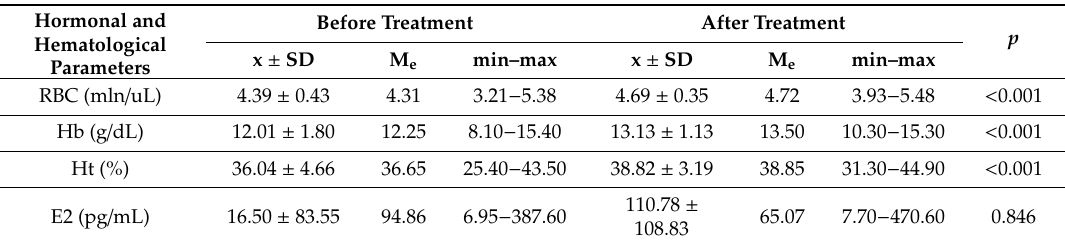
Table 8. Hormonal and hematological parameters of blood serum before and after 3 months of fibroids treatment with ulipristal acetate ( n = 34